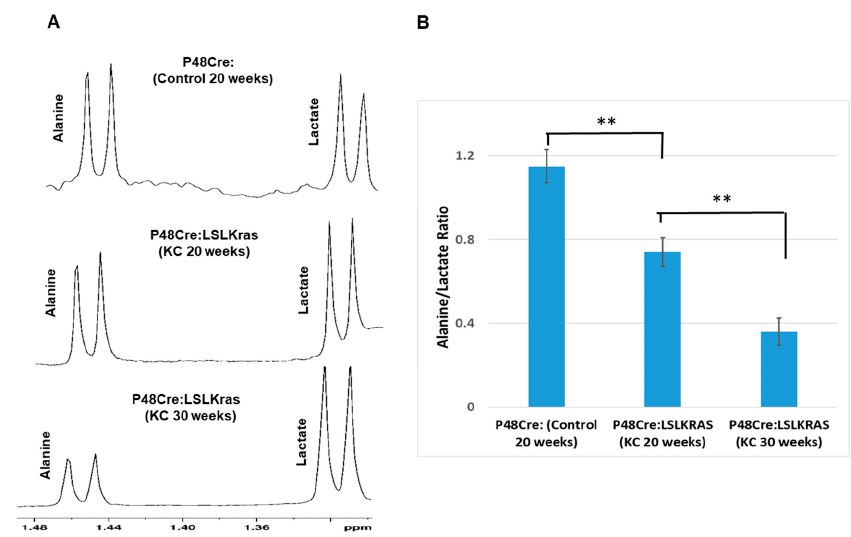
Figure 2. ( A ) Steady-state high-resolution nuclear magnetic resonance ( 1 H- NMR) spectra of ex vivo tissue samples for different mouse groups ( n = 10). The alanine and lactate peak intensity alters inversely with PanINs progression. For alanine, it decreases, but lactate peak intensity increases as the PanINs progress from early to advanced stage. ( B ) The net ratio of alanine to lactate (Alanine/Lactate) gradually reduces with PanINs progression to advanced stages. ** means p < 0.001.